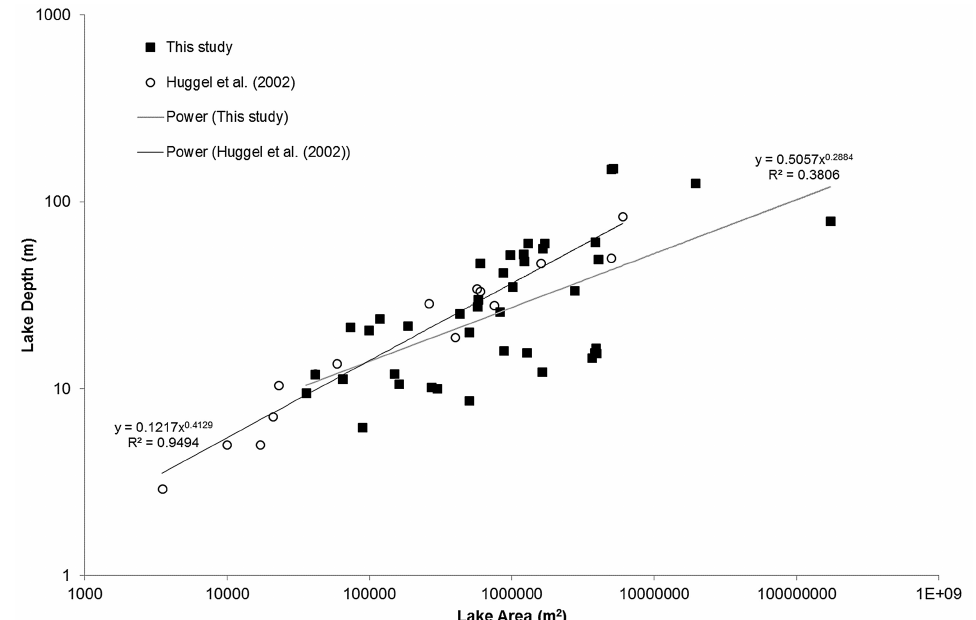
Figure 1. Plot of lake area vs. depth for the data compiled in this study (including duplicate measurements of individual lakes) and the data presented by Huggel et al. (2002). Best-fit lines and corresponding equations and r 2 values are presented for both data sets.